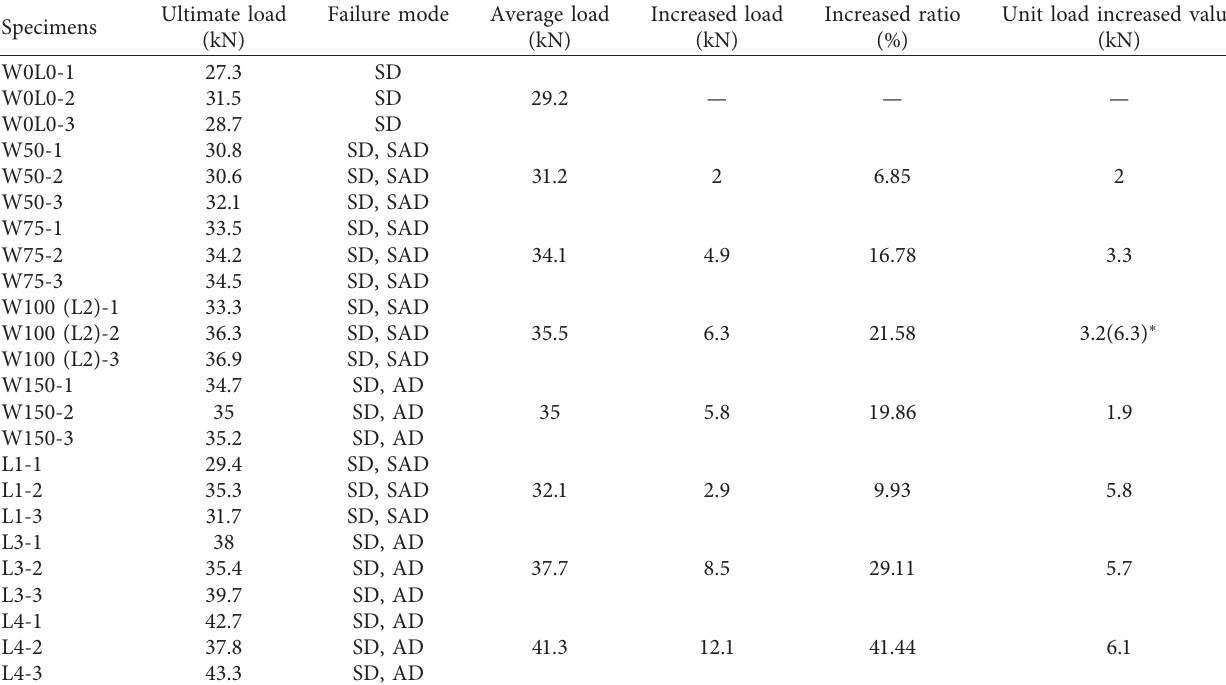
Table 3: Ultimate bearing capacities of test specimens.